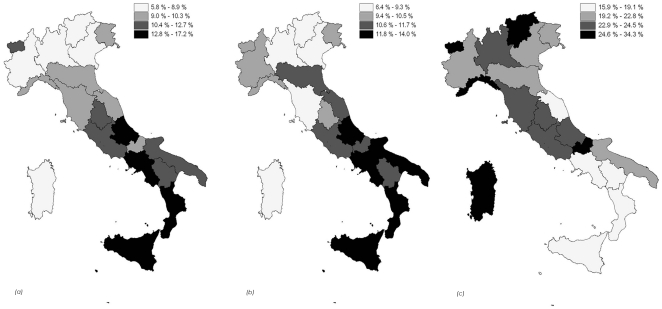
Geographical distribution of overweight (a), EAT26 >20 (b), substance use (c), expressed as percentage.